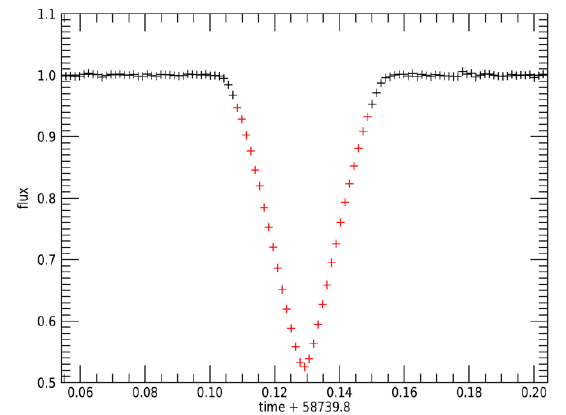
Figure 2. Light curve of the first complete primary eclipse in the TESS data, at BJD 2458739.9291. The y-axis represents flux values that are normalized to the off-eclipse flux using the procedure described in the text and the x axis indicates BJD-2400000. Points shown in red have a flux of <0.95, which are those that were used as input for the Kwee–van Woerden (KvW) algorithm.